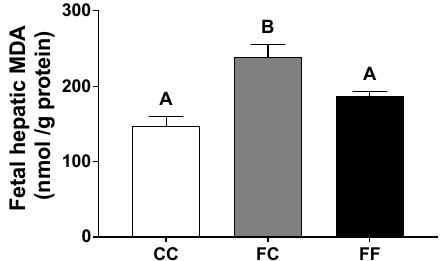
Figure 6. Pregnancy in progeny from fructose-fed mothers produces higher fetal hepatic oxidative stress than ingestion of a 10% wt/vol fructose solution throughout gestation in pregnant rats from fructose-fed mothers. Hepatic MDA values of fetuses from 21-day-pregnant rats from control mothers (CC, empty bar), or pregnant rats from fructose-fed mothers subjected (FF, black bar) or not (FC, grey bar) to fructose intake throughout pregnancy. Data are mean ± S.E. from n = 5 liver pools of the fetuses of the same litter. Values not sharing a common letter are significantly different ( p < 0.05) between the three groups.